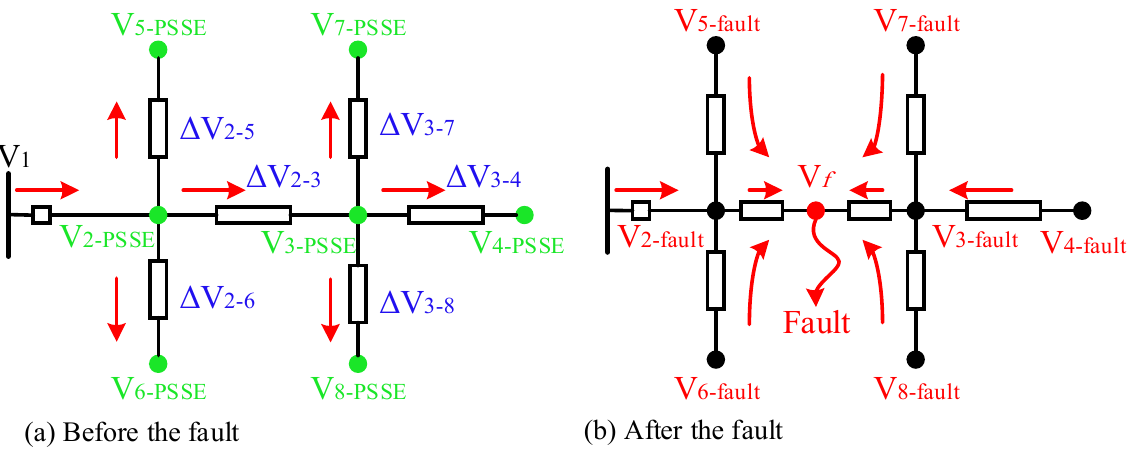
Figure 4. Network status. ( a ) Information obtained from the PSSE before the fault, ( b ) The current direction of each network line after the fault.